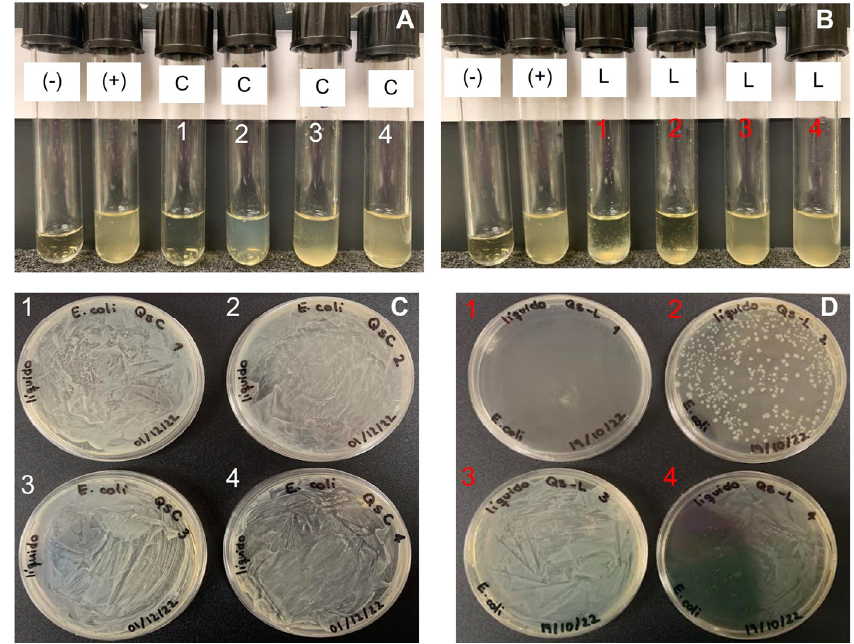
Figure 8. Antimicrobial activity of crab chitosan (crab chitosan: C) in a broth macrodilution assay against E. coli ( A ). Antimicrobial activity of lobster chitosan (lobster chitosan: L) in a broth macrodilution assay against E. coli ( B ). Growth on plates of crab chitosan assay ( C ) and lobster chitosan assay ( D ). In crab chitosan tube 1: 1.5 mg/mL, tube 2: 0.375 mg/mL, tube 3: 0.1 mg/mL and tube 4: 0.02 mg/mL. In lobster chitosan, concentrations for tube 1 to 4 were 3.34 mg/mL, 1.11 mg/mL, 0.37 mg/mL and 0.125 mg/mL respectively.